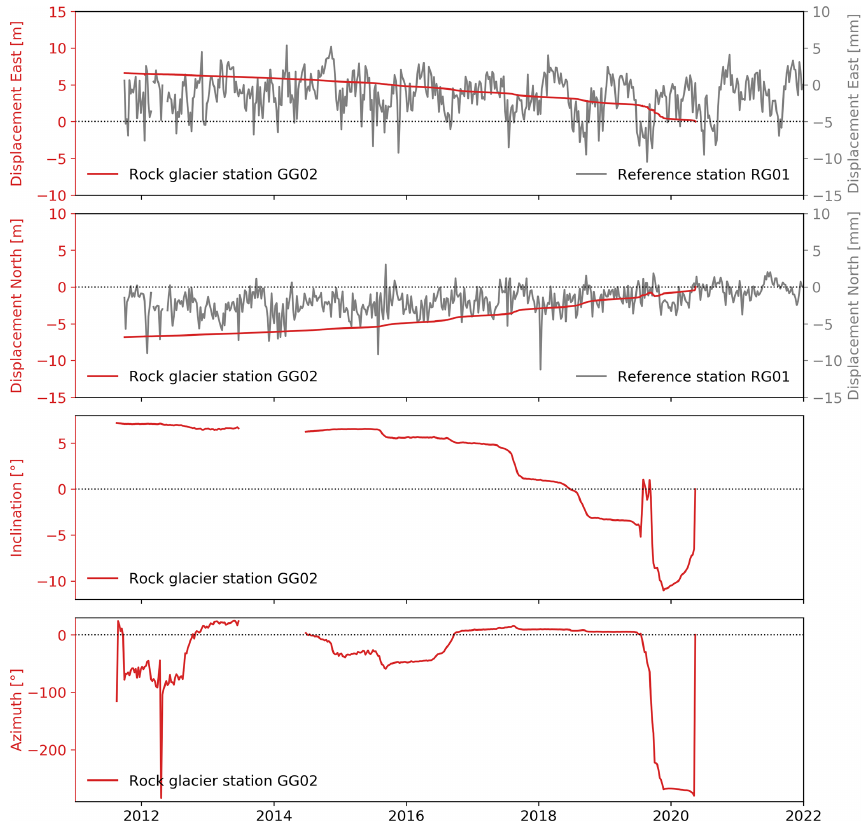
Figure B2. A decade of displacement, inclination, and azimuth for the Grabengufer rock glacier (position GG02). In 2020, the boulder where the GNSS station was installed showed an anomalous behaviour and strong acceleration until falling into the gully. The data show this process until the last